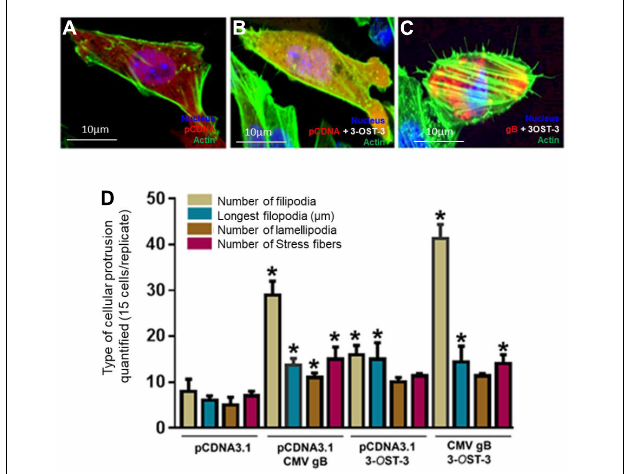
FIGURE 3 | Co-expression of HCMV glycoprotein B (gB) together with 3- O sulfated heparan sulfate (3- O S HS) efficiently enhances the cellular filopodial protrusions in the CHO-K1 cell model. Several combinations were used in this experiment to image and quantify filopodia. Individual CHO-K1 cells were separately transfected with pDsRed encoding pCDNA3.1 plasmid (A) , plasmid encoding 3- O ST-3 enzyme alone (B) , and co-transfected with HCMV-gB together with 3- O ST-3 plasmid (C) . The DNA concentration was kept constant throughout the experiment. The cells were fixed 12 h post-transfection and imaged for quantification of cellular protrusions. (D) Quantification of cellular protrusions (filopodia, length, lamellipodia and stress fibers) is being compared between CHO-K1 cells expressing pCDNA3.1, HCMV gB, 3- O ST-3, and 3- O ST-3 along with HCMV gB. The quantification is based on 15 cells randomly picked per triplicate experiment. Asterisks indicate significant difference from controls and/or treatments ( p < 0.05, t -test), and error bars represent